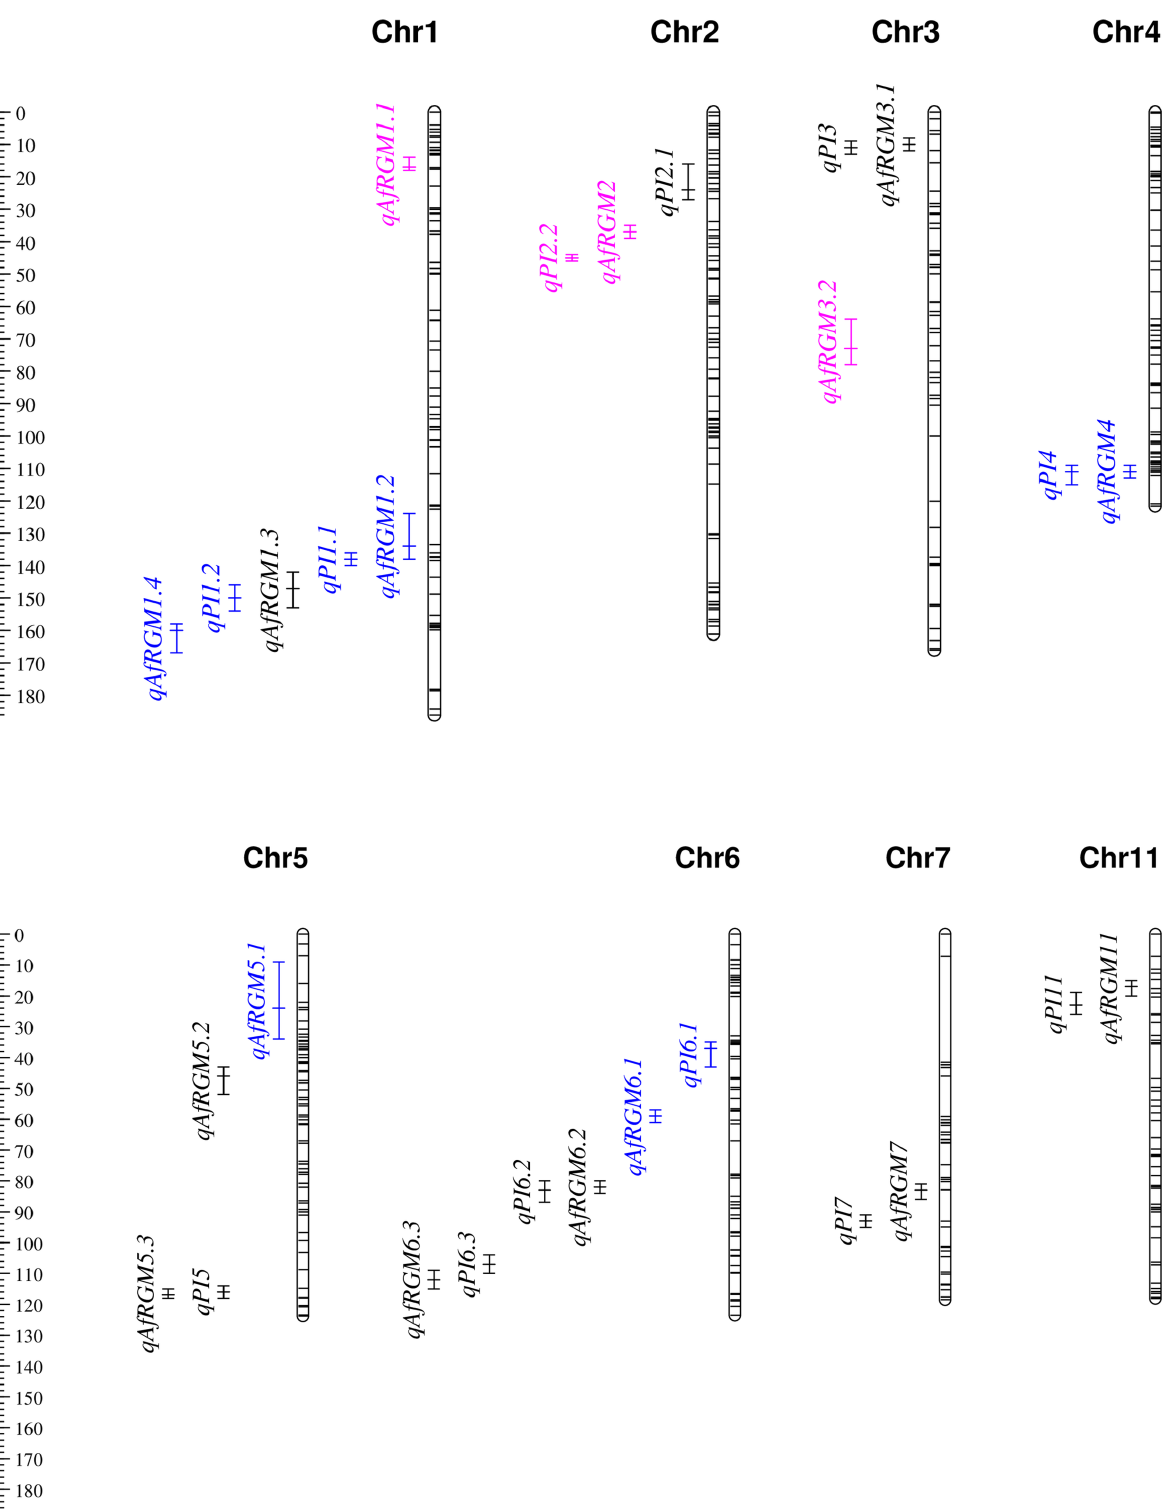
Fig 3. The positions of the 28 QTLs associated with African gall midge incidence ( qPI ) and severity ( qAfRGM ) in the ITA306xTOG7106 (black font), ITA306xBW348-1 (pink font) and ITA306xTOS14519 (blue font) populations. The vertical ruler on the left shows map position in centiMorgan. QTL are shown on the left side of each chromosome, with vertical bars indicating their 95% confidence interval. See Table 1 for details on each QTL and S1 Table for details on marker positions. doi:10.1371/journal.pone.0160749.g003 PLOS ONE | DOI:10.1371/journal.pone.0160749 August 10,